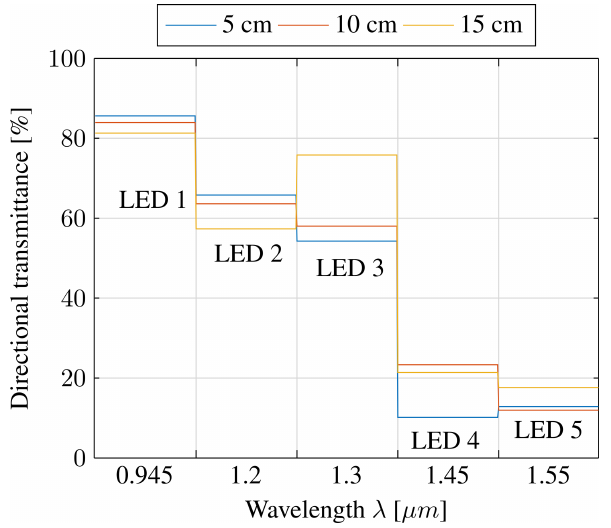
Figure 13. Measured directional transmittance at a distance of 5cm for increasing water film heights from 1 to 10mm with black tile